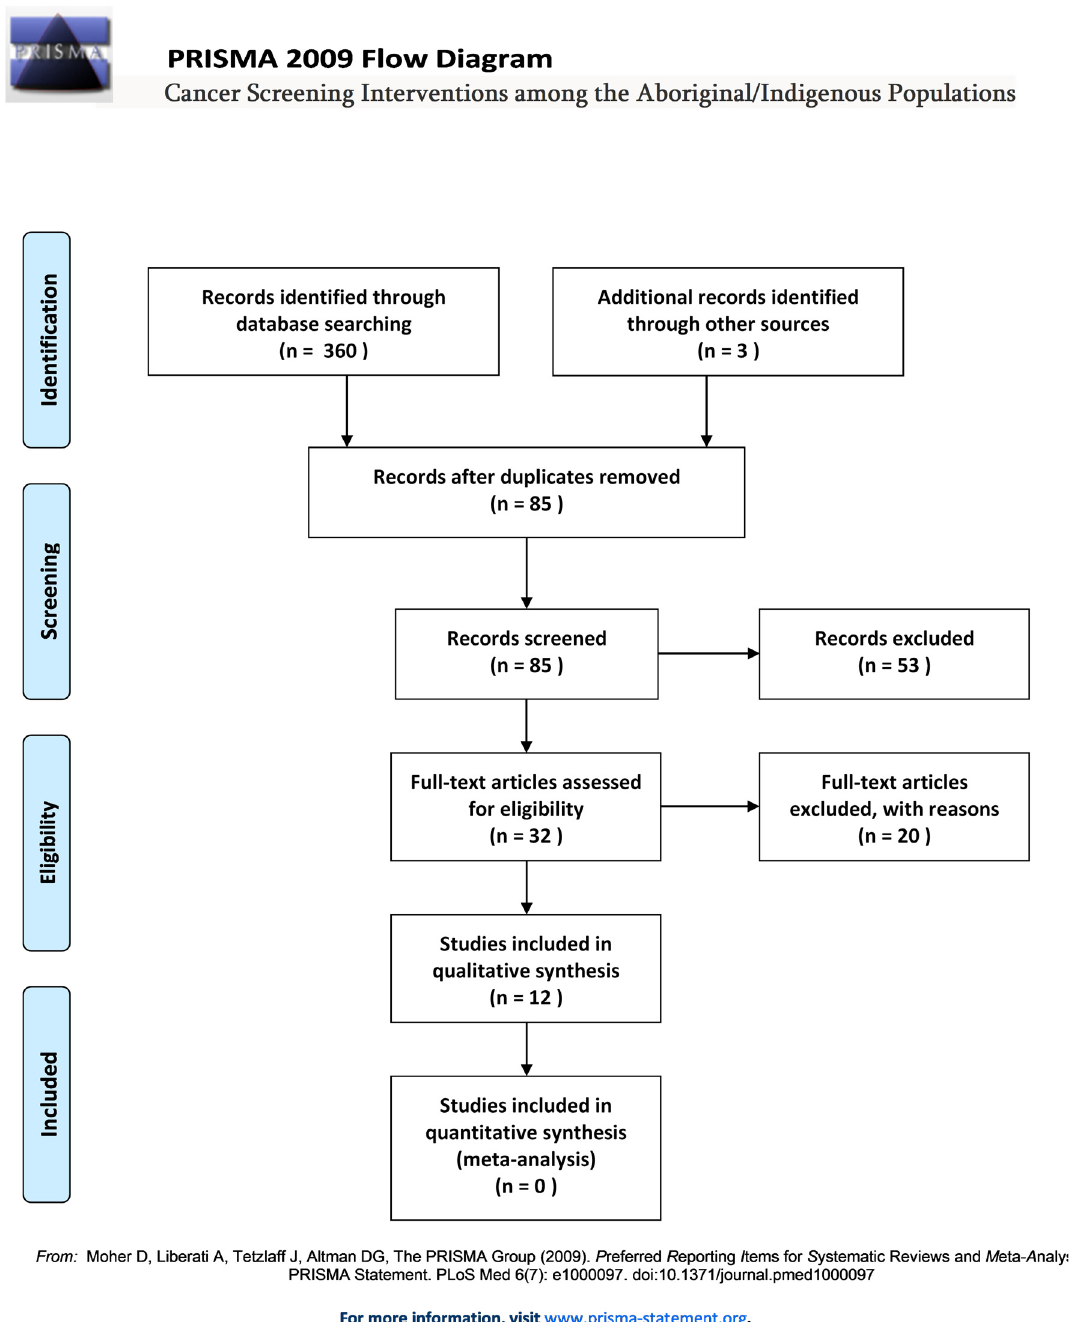
Figure 1. PRISMA flow diagram.